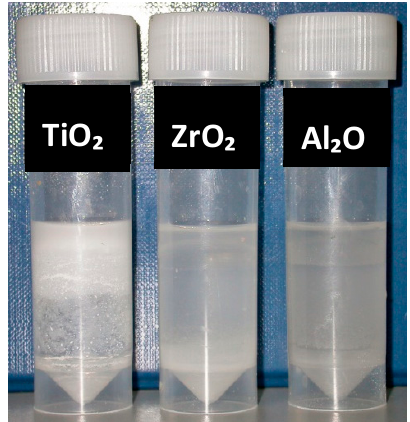
Figure 11. Particles subsequent to silane treatment, method III, mixed with monomer and stored for one hour from left to right; silane treated TiO 2 , ZrO 2 and Al 2 O 3 .